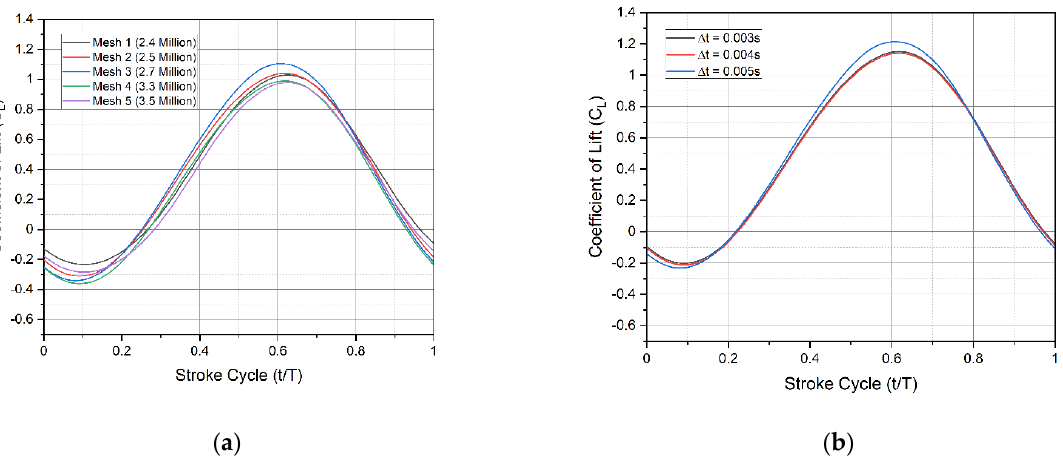
Figure 6. ( a ) Grid independence study and validation for a number of cells with normalized vertical force as a parameter of study for each stroke cycle; ( b ) time-step independence study and temporal evolution of mean lift as a parameter of study for different time-step in each stroke